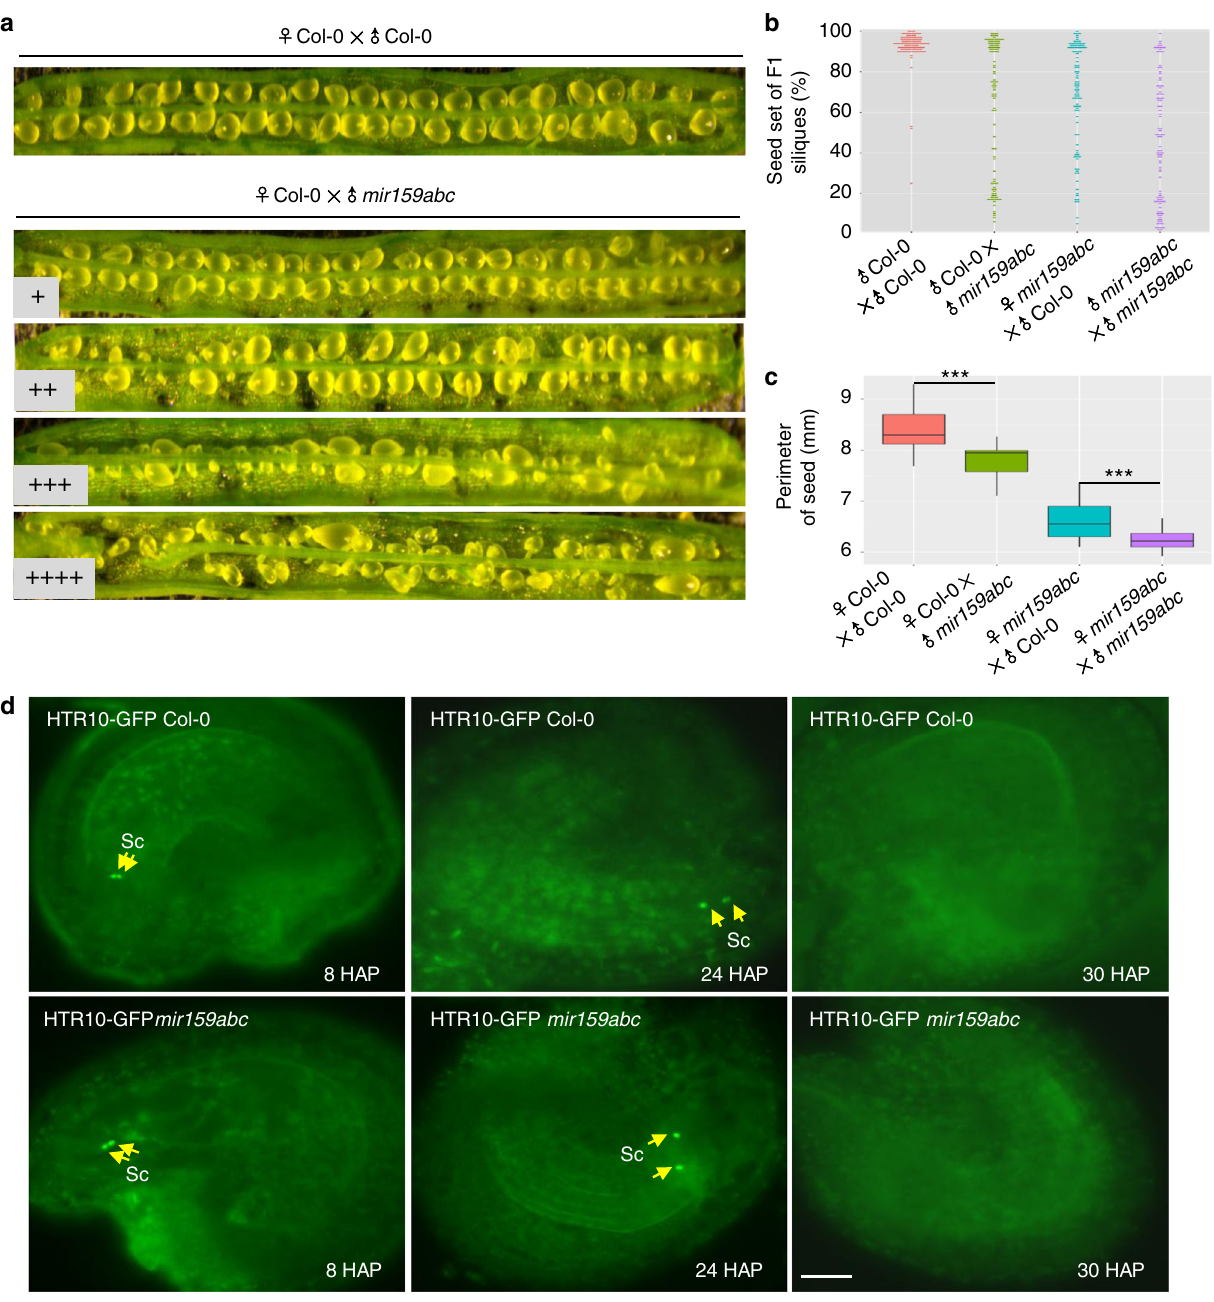
Fig. 1 Both maternal and paternal miR159 are required for seed development. a Representative F1 siliques from 6 DAP (Day After Pollination) ♀ Col- 0 × ♂ Col-0 and ♀ Col-0 × ♂ mir159abc , respectively. Smaller one from three lower panels indicates aborted seeds when Col-0 was pollinated by pollen of the mir159abc triple mutant. F1 siliques were divided into 4 categories according to % of seed set per silique: >90% ( + ), 60 – 90% ( ++ ), 30 – 60% ( +++ ), <30% ( ++++ ), respectively. Source data are provided in the accompanying Source Data fi le. b Statistical analysis of seed set from a . The percentage of seed set per silique for each genotype is shown. One hundred siliques for each genotype were shown, and each dot represents one silique. c Statistical analysis of average perimeter per seed from each category. Perimeters of 20 seeds randomly picked from indicated genotypes were measured using the Image J software. Box plot shows the distribution of each seed perimeter for each genotype, and asterisks indicate a signi fi cant difference between the indicated samples ( t -tests, P -value <0.05). d The release and migration of twin sperm in the developing seeds of Col-0 and the mir159abc triple mutant. Pistils from Col-0 and the mir159abc triple mutant harboring the HTR10-GFP transgene were self-pollinated, and the developing seeds at indicated time were dissected and imaged by fl uorescence microscope. >50 developing seeds for each genotype were analyzed and representative images were shown. The yellow arrows indicate two released sperm. Embryo sacs are green due to auto- fl uorescence. Scale bar, 20 µ